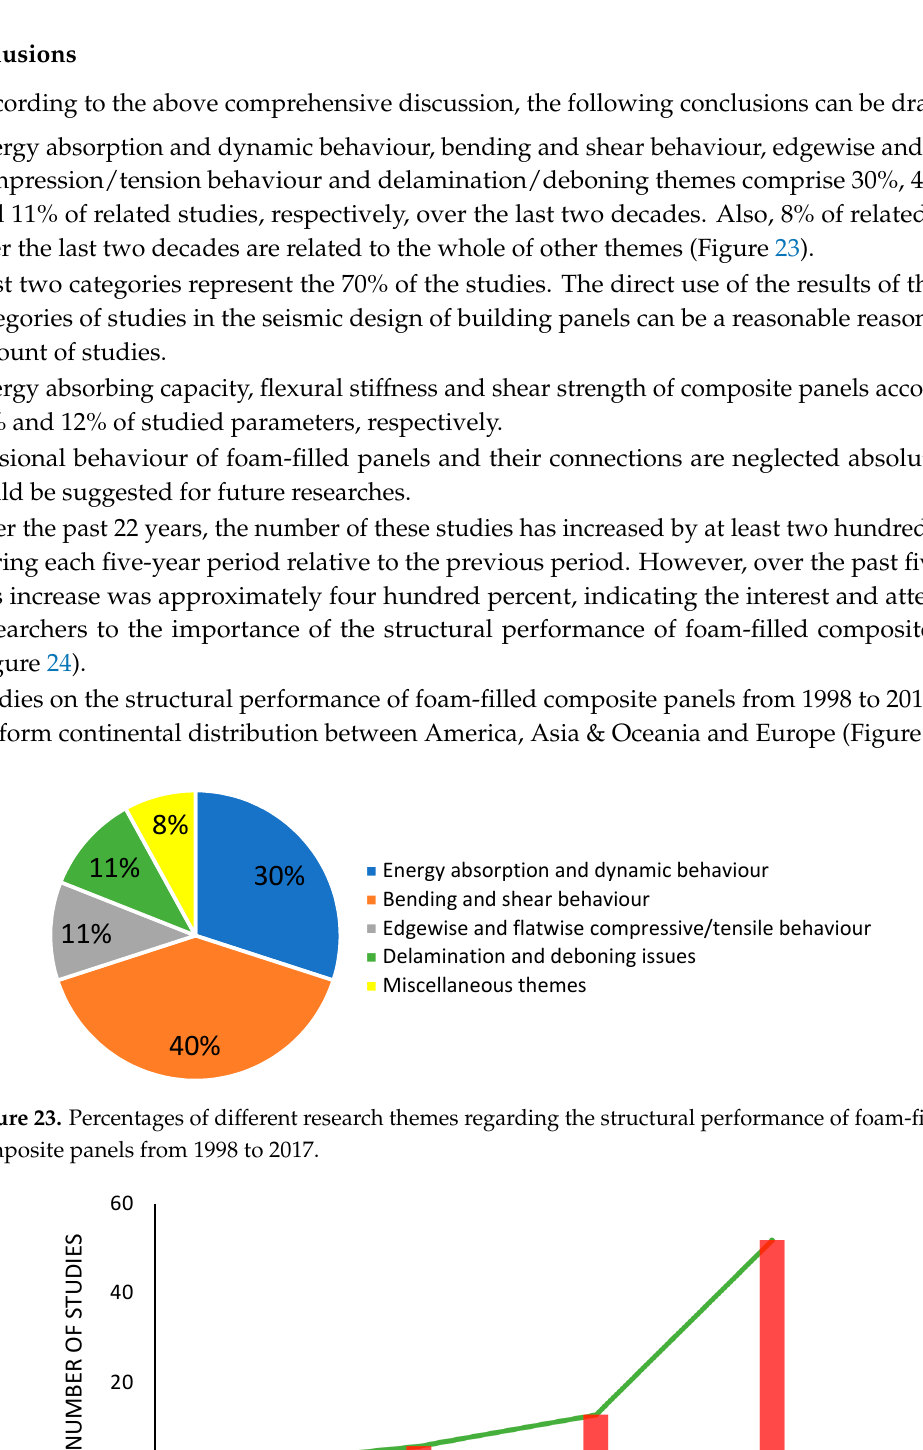
Figure 24. Growing up of studies on the structural performance of foam-filled composite panels from 1998 to 2017.